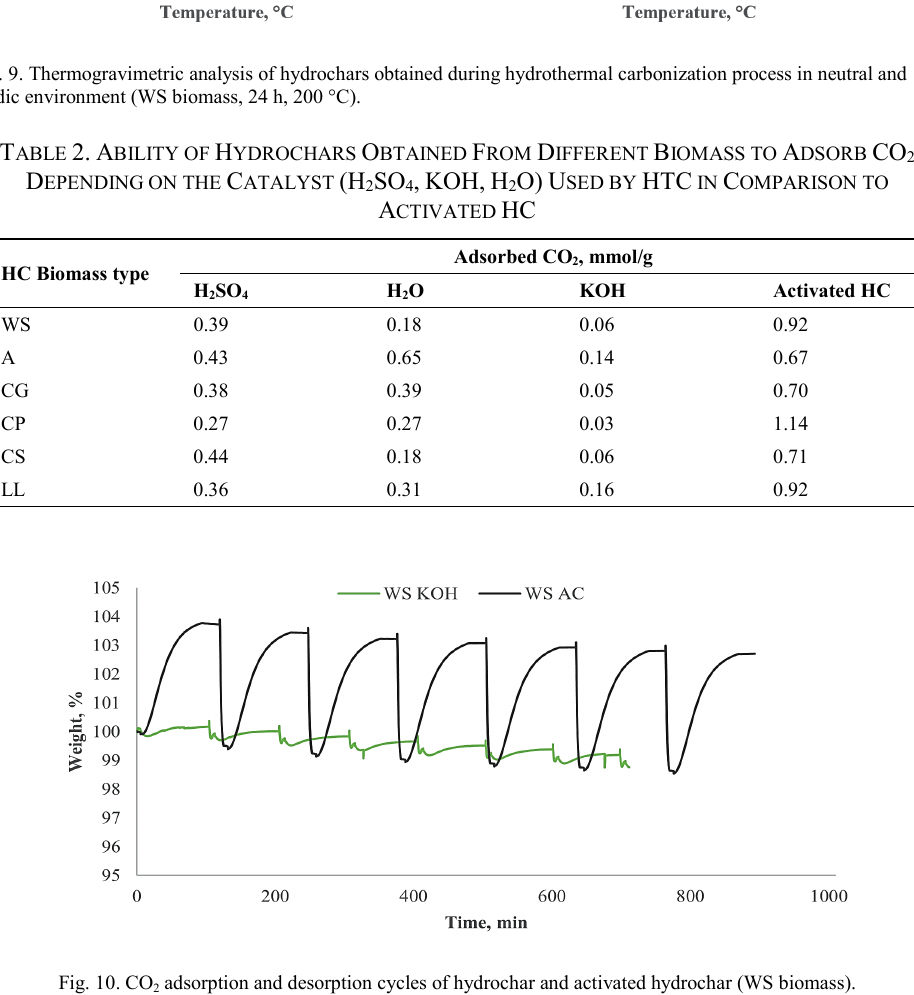
Fig. 10. CO 2 adsorption and desorption cycles of hydrochar and activated hydrochar (WS biomass). The ability of obtained HCs to adsorb carbon dioxide was evaluated using the approach of cyclic CO 2 sorption analysis on thermogravimeter (Fig. 10). The CO 2 adsorption values